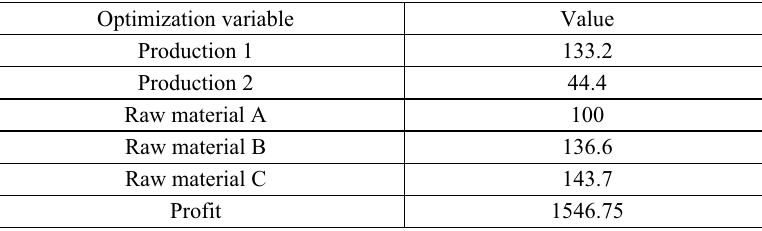
Table 5. Sequential scheduling profit